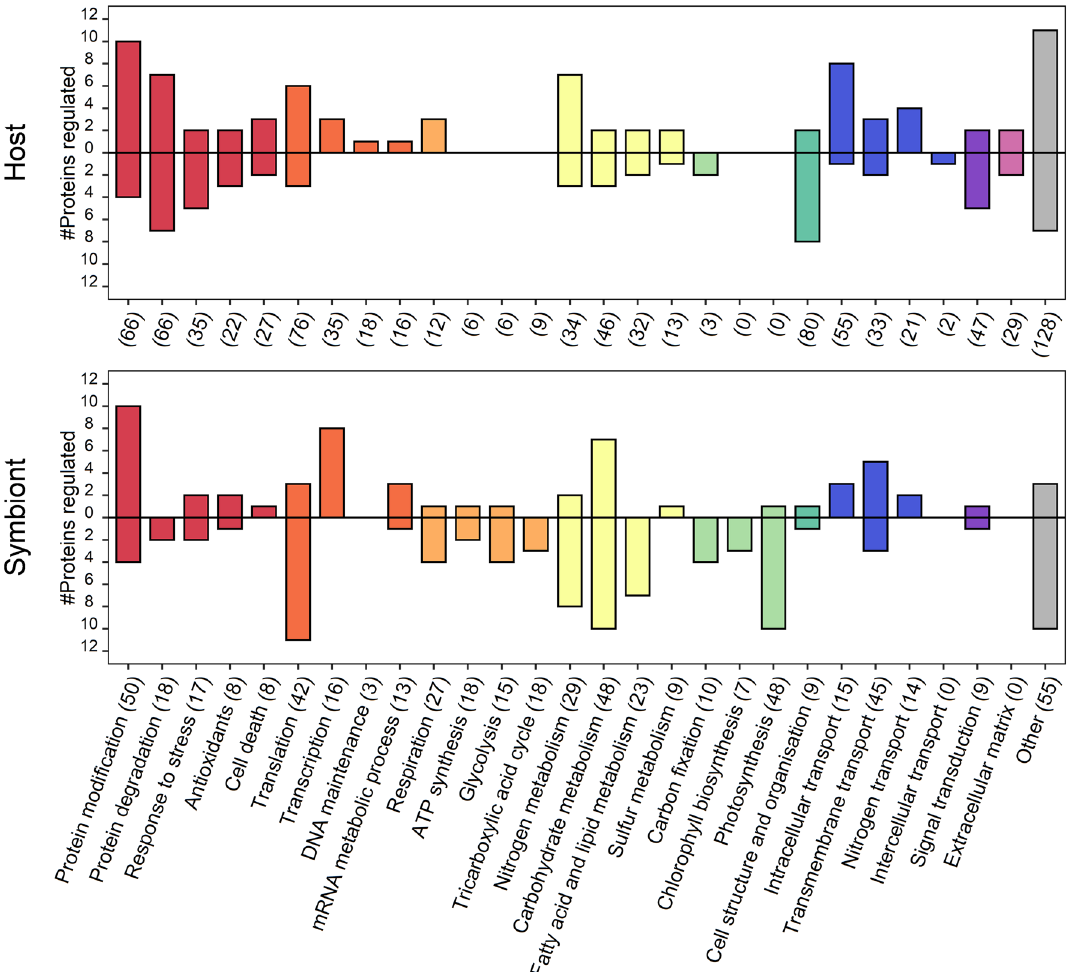
Figure 4. Number of differentially expressed proteins detected in the host and symbiont of Acropora millepora grouped by sub-categories. Positive bars show the number of proteins that increased in abundance, while negative bars show the proteins that decreased in abundance with elevated temperature. Numbers in parentheses on the x-axis indicate the total (including unchanged) number of proteins detected for each sub-category. Colours represent major functional groups, as described in the legend of Fig.